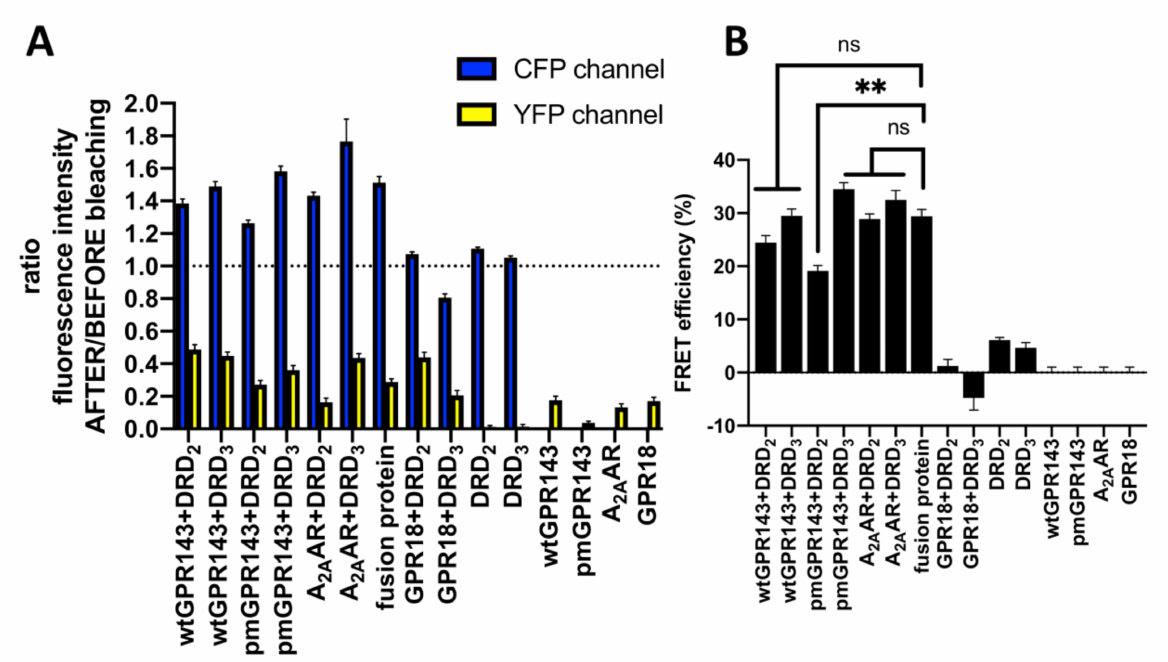
Figure 3. Quantification of acceptor photobleaching FRET. Wt or pmGPR143-YFP, A 2A AR-YFP or GPR18-YFP and DRs-CFP (DRD 2 or DRD 3 ) were co-transfected in COS7s. ( A ) Ratio of emission intensity after:before bleaching was determined. Controls = single transfected COS7s, DRs-CFP + GPR18-YFP, and CFP-YFP fusion protein; ( B ) FRET efficiency was quantified for co-transfected COS7s. Controls = Single transfected cells, DRs-CFP + GPR18-YFP, and CFP-YFP fusion protein. Data represent means ± SEM of three independent experiments; on average, 92 ± 9 ROIs were analyzed per sample. Significant differences between controls (single transfected and +GPR18 samples) and treatment samples including the positive control CFP-YFP fusion protein were observed. Wt and pmGPR143 and A 2A AR-transfected samples did not differ from the CFP-YFP fusion-protein, except for pmGPR143+DRD 2 . Values refer to limited regions (see Figures S3 and S4). * = p < 0.0001, ns = not